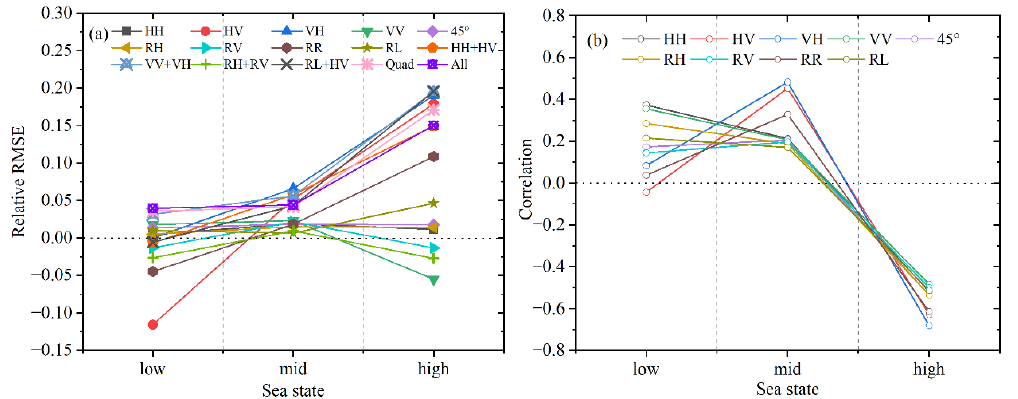
Figure 13. ( a ) The effects of removing NRCS-terms on the model performance of different polariza- tions under different sea states. ( b ) The correlation between NRCS of different polarizations and SWH under different sea states.